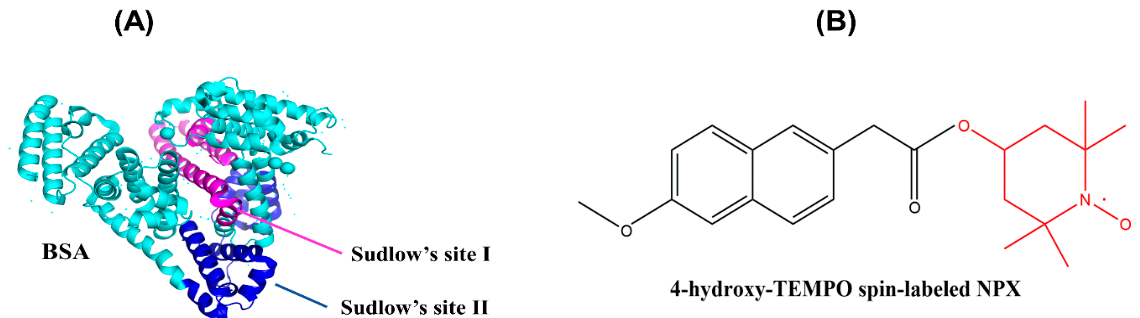
Figure 1. ( A ) Three-dimensional structure of BSA and its drug-binding sites (the protein topology from PDB ID 4f5s) and ( B ) chemical structure of SL-NPX.